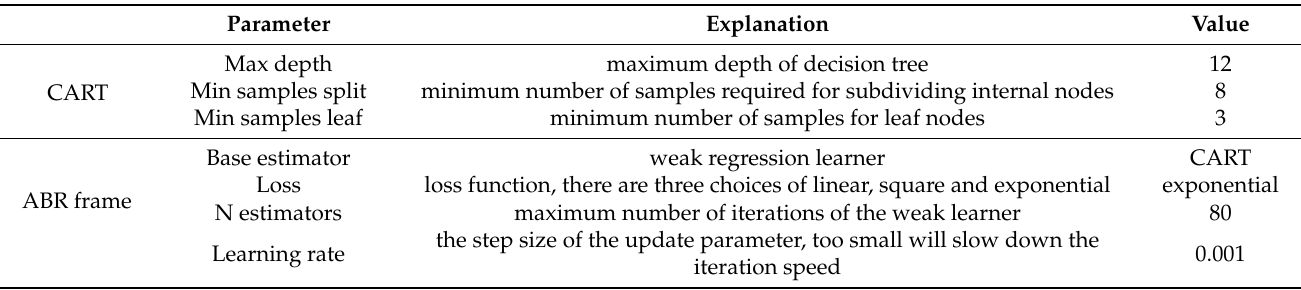
Table 3. Selection of model parameters.